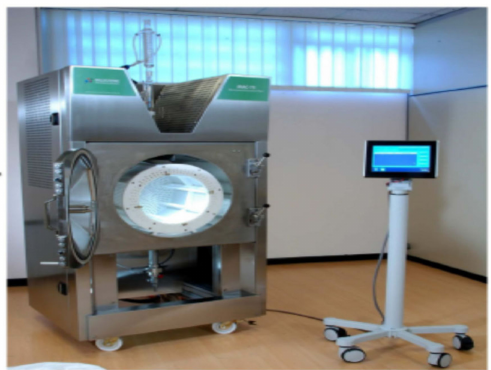
Figure 10. The setup of the industrial scale microwave extractor MAC 75/Milestone Technologies. The extraction trials of the orange pomace samples were conducted following the procedure described below. The frozen orange samples were first thawed at ambient temperature and 2 Kg of each sample were then collected and used as the extraction sample. The 2 Kg orange pomace sample was first put in a plastic basket which was then adjusted to the extraction cavity of MAC-75 vacuum-microwave extractor. Consequently, the machine door was closed and filled with the appropriate quantity of distilled water. The quantity of the water used in each trial was according to the water/solid ratio suggested by the experimental plan (shown in Table 1). In addition, the desired values of microwave power and extraction time were set via the electronic panel of the extractor, according